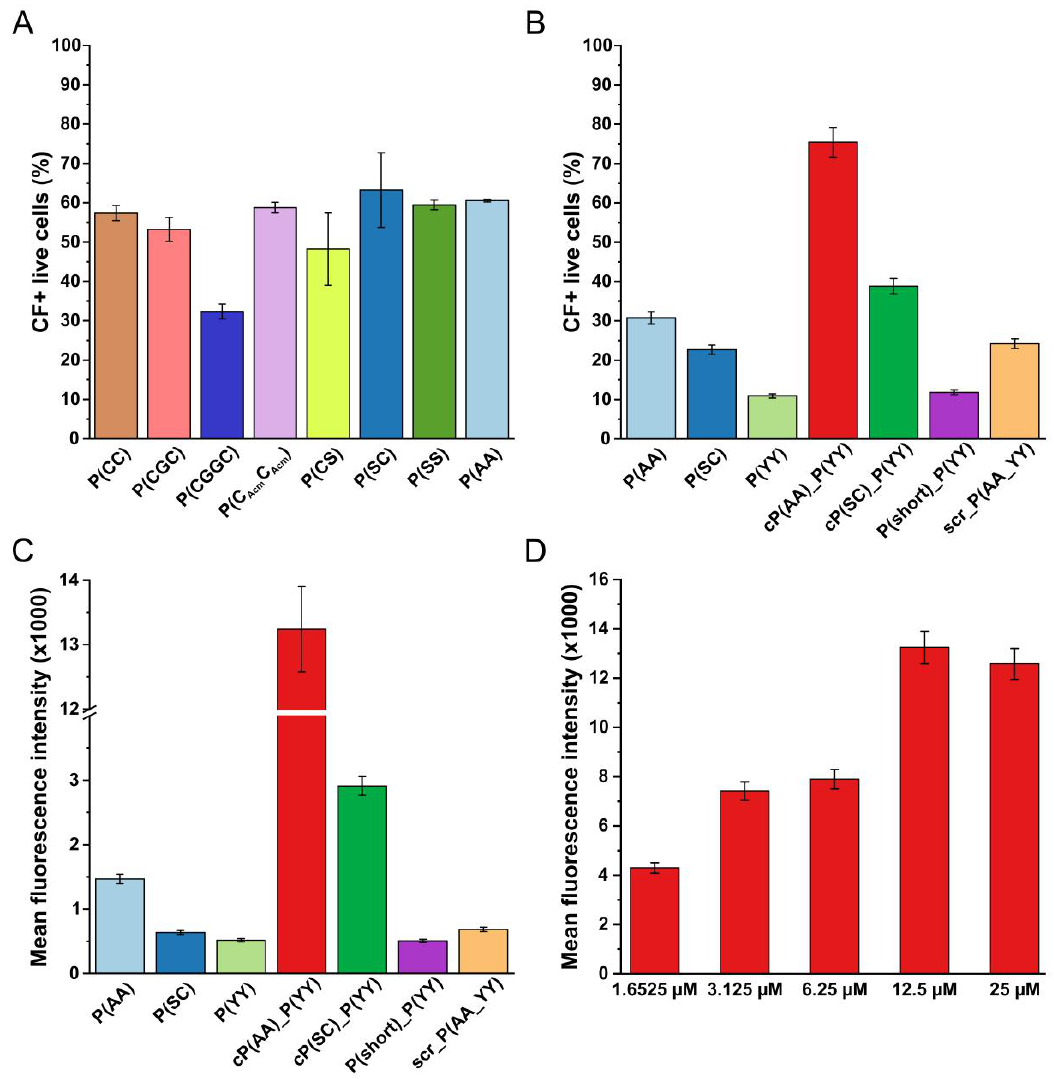
Figure 2. Cellular uptake profile of 5(6)-carboxyfluorescein (CF)-labeled HER2 binding peptides using MDA-MB-453 breast cancer cells. ( A ) Comparison of the first set of peptides using a 1 h incubation time and a concentration of 100 µM. ( B,C ) Cellular uptake (percentage of CF+ live cells and mean fluorescence intensity) of the most promising conjugates from the first set of peptides, the peptide chosen from the molecular dynamics (MD) simulation and “one bead one compound” (OBOC) library and combined peptides using 3 h incubation time and a concentration of 12.5 µM. ( D ) Concentration dependence of cellular uptake of conjugate cP(AA)_P(YY), mean fluorescence intensity after 3 h of incubation. Flow cytometry was measured by a BD LSR II flow cytometer. The mean and standard deviation of two parallels are depicted. The experiments were repeated twice.